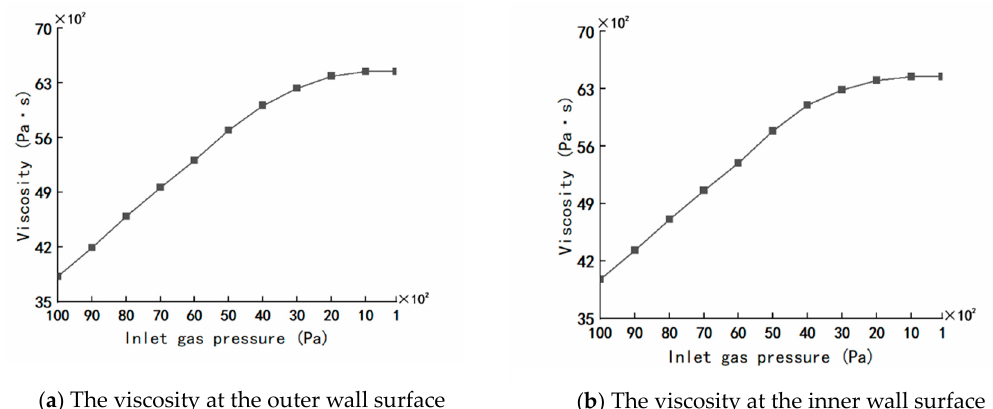
Figure 16. The viscosity at the wall surface of the melt under different inlet gas pressures. ( a ) The viscosity at the outer wall surface; ( b ) The viscosity at the inner wall surface.